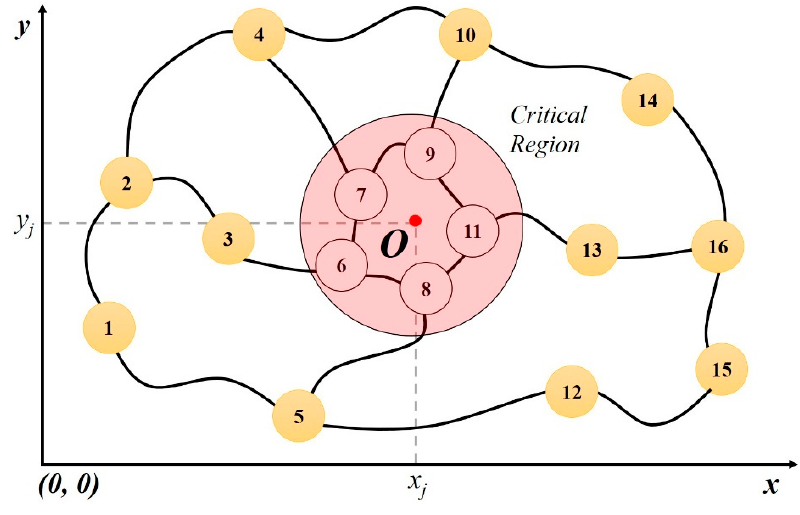
Figure 4. Critical region failures embedded in xy ‐ plane.